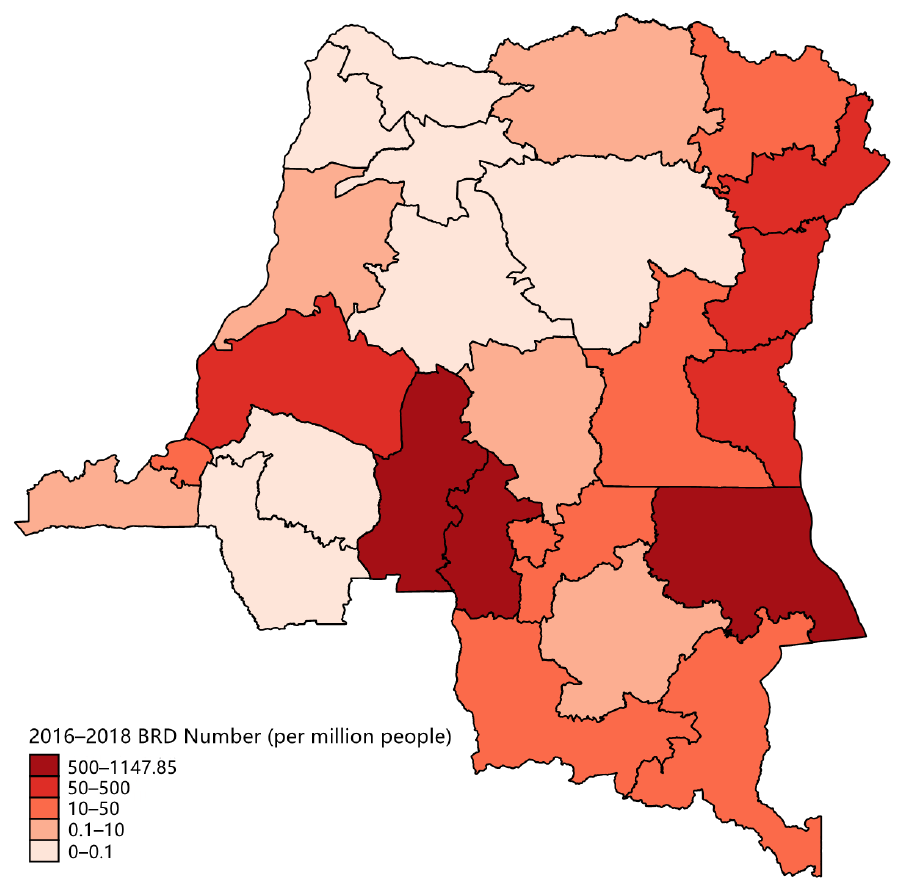
Figure 1. Different levels of conflict severity in each province in the DRC.